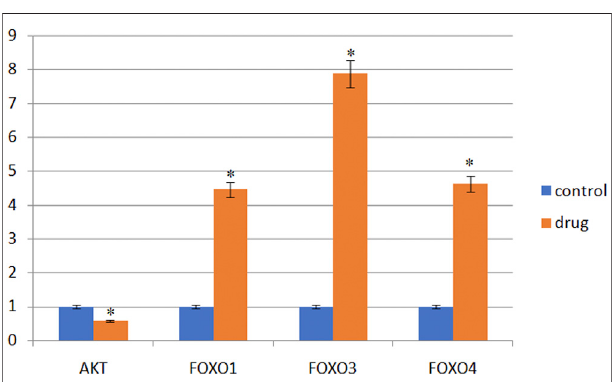
FIGURE 5 | Gene expression in SMMC-7721 cells ( ‾ X ± s). Note: *Compared with the control group, it is statistically signi fi cant ( p < 0.05).